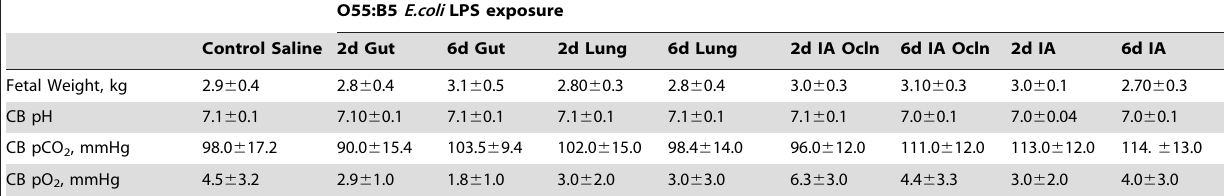
Table 2. Physiological variables at